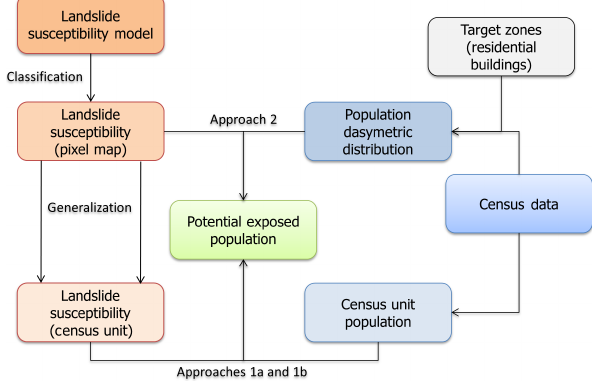
Figure 2. General methodological work